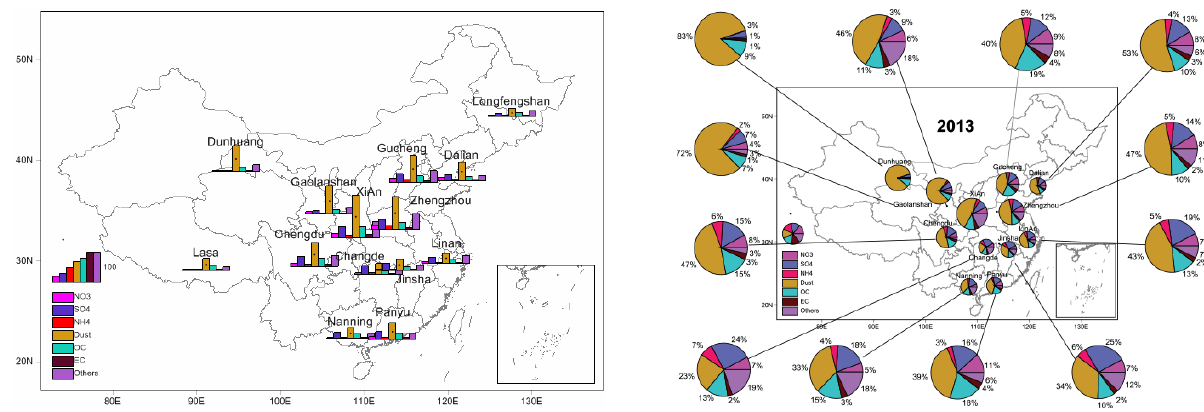
Figure 2. (a) Averaged mass concentrations (µgm − 3 ) of major chemical components in 13 stations during 2006–2010. (b) Chemical pro- portions of PM 10 in 2013. Table 1. Proportion change in major chemical components of PM 10 at